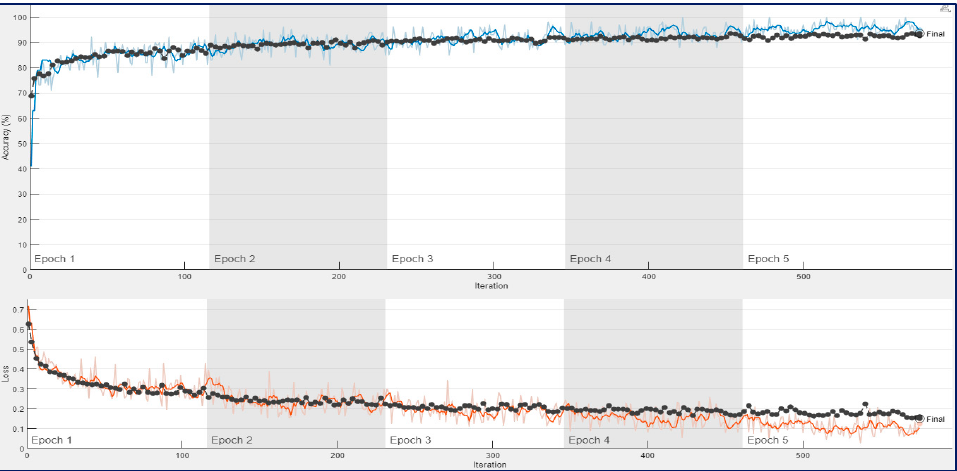
Figure 10. Training process result for ConvMixer with 12,800 spectrogram images in a trial on the